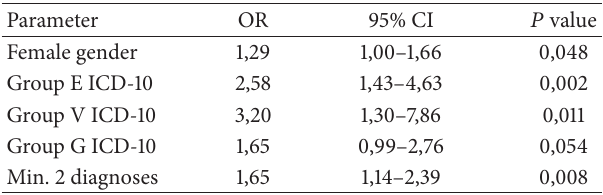
Table 2: The values of the OR of OHSCA in patients at potential risk factors for this complication, as defined in the univariate logistic regression analysis.